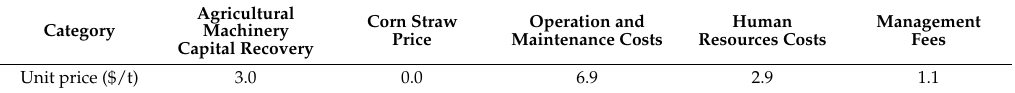
Table 2. The summarized cost table of corn straw collection ( i = 0.08 and n = 10).